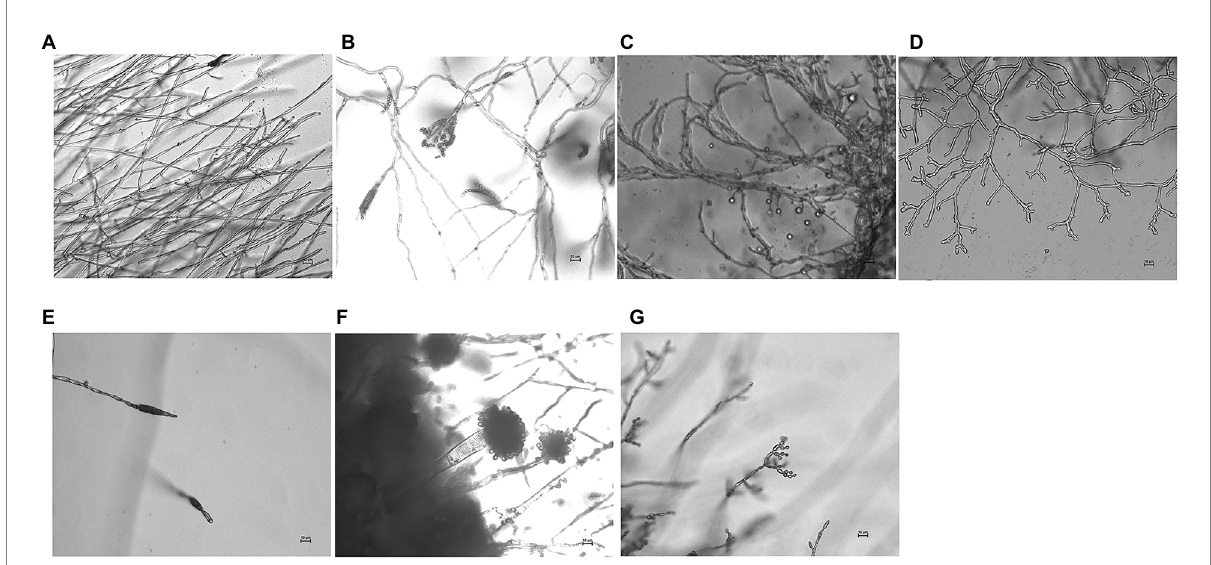
FIGURE 5 Micromorphology of fungi isolated from the surface of pottery figurines. The fungi were inoculated onto the PDA medium and incubated at 28 ° C for 3 days. The scale is 10 μ m. (A) L. aphanocladii (NK-PF1). (B) P. aurantiogriseum (NK-PF2). (C) C. rosea (NK-PF3). (D) Mortierella sp. (IPF4). (E) M. alpina (NK-PF5). (F) A. flavus (NK-PF6). (G) C. halotolerans